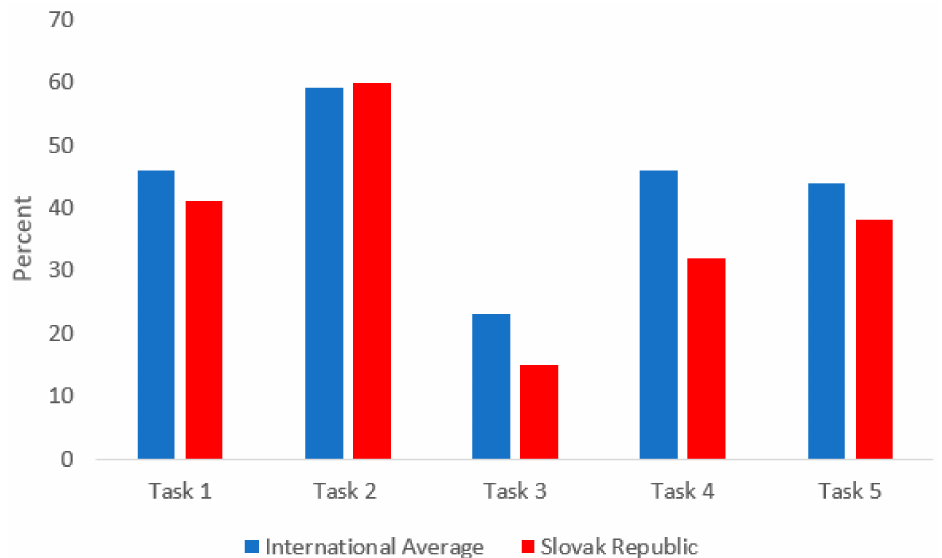
Figure 5. Slovak pupils’ results in comparison with the international average. Slovak pupils achieved a lower average score in four tasks from five than the interna- tional average. They were only more successful on the task in which pupils had to shade one half. The biggest difference to the detriment of Slovak students was in task 4, where it was necessary to choose from the fractions the one that is equivalent to one half. Slovakia achieved a success rate of 32% in this task; the international average was 46% [26]. The fractions tasks were in TIMSS in 2015 and 2019. In comparison with the EU and OECD countries, Slovak pupils achieved a success rate of only 16% in 2015 and 23% in 2019. The international average was 42% in 2015 and 47% in 2019